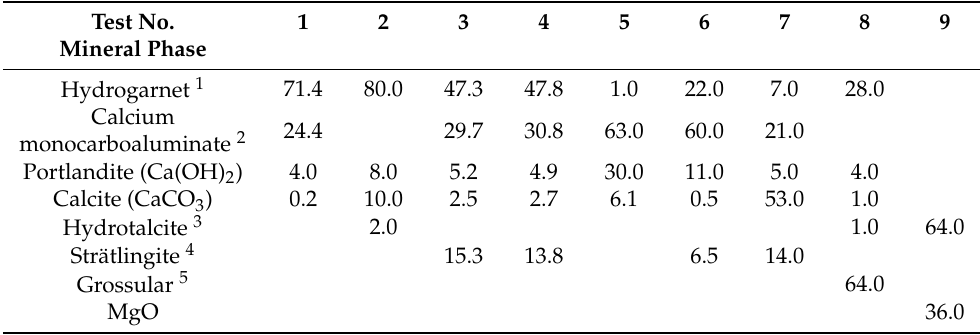
Table 4. XRD analysis quantifying mineral phases by wt% in solid residue.